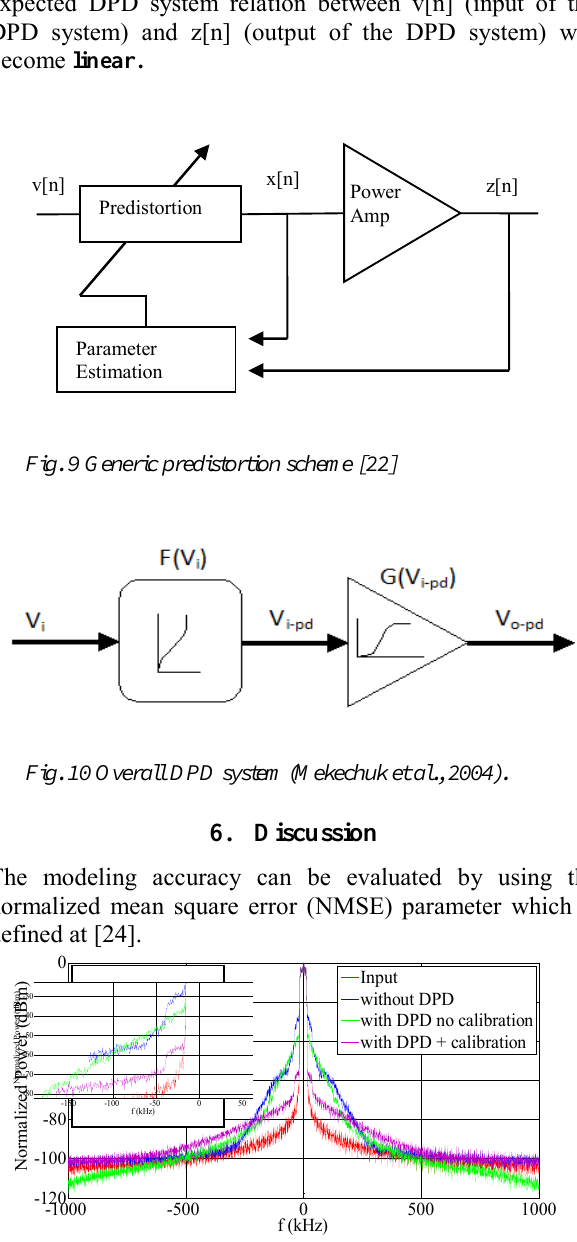
Fig. 11 Frequency spectrum of the measured data (input and output) and simulated data (un-calibrated and calibrated DPD output)